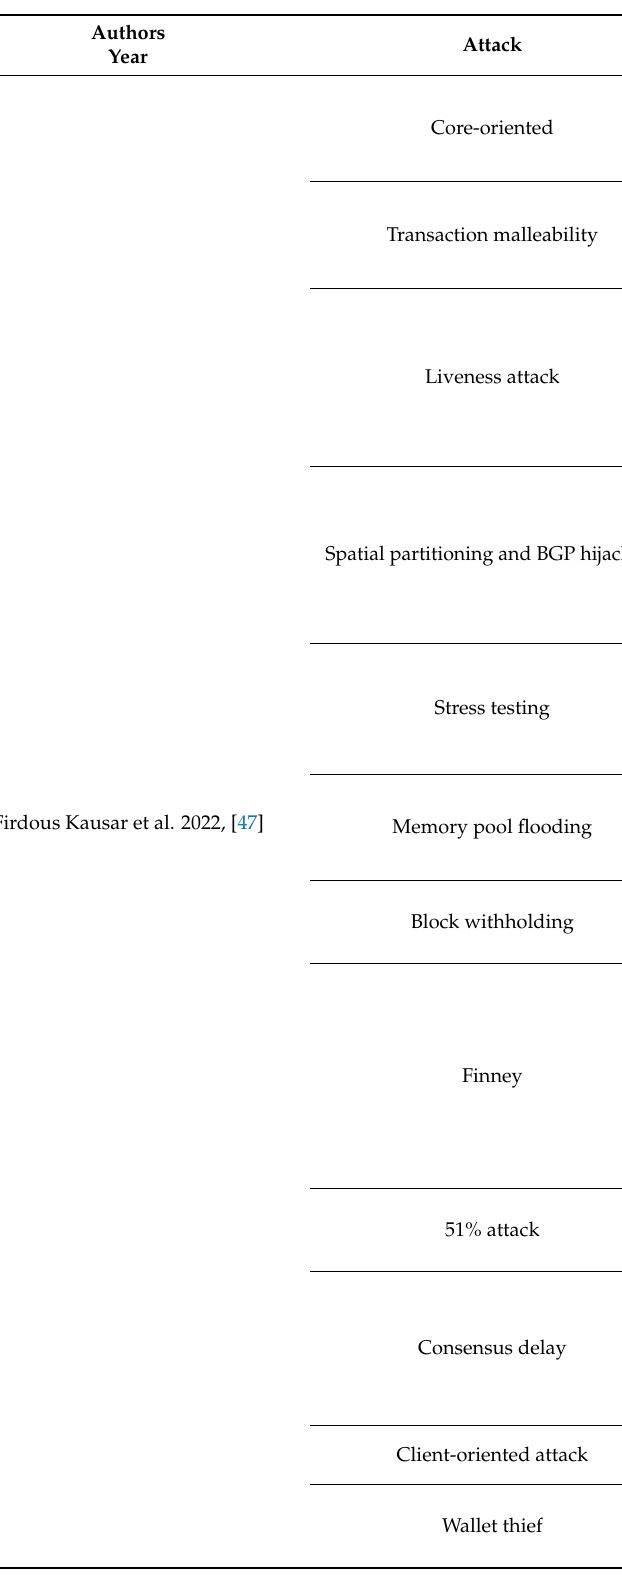
Table 3. Attacks on the blockchain with